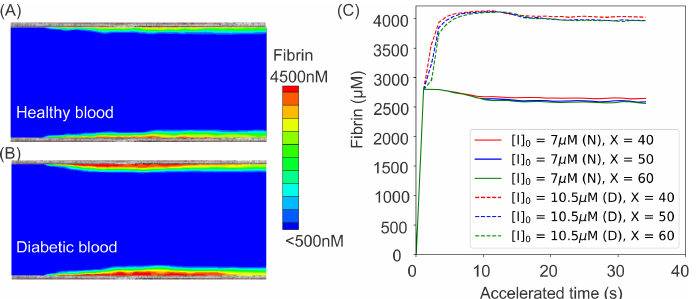
Figure 8. Simulation results of fibrin ([Ia]) concentration boundary layers in the middle cross-section of the microchannel for ( A ) normal and ( B ) diabetic blood. ( C ) Variation of fibrin concentration over time at three different sites of x = 40, 50, 60 µ m for normal blood (solid lines) and diabetic blood (dashed lines). To investigate the effects of diabetic blood in promoting fibrin generation, an initial concentration of [I] 0 = 7 µ M is prescribed in normal blood model while [I] 0 = 10.5 µ M is used in the diabetic blood model. (N) represents normal blood whereas (D) designates diabetic blood. The figure is reproduced from